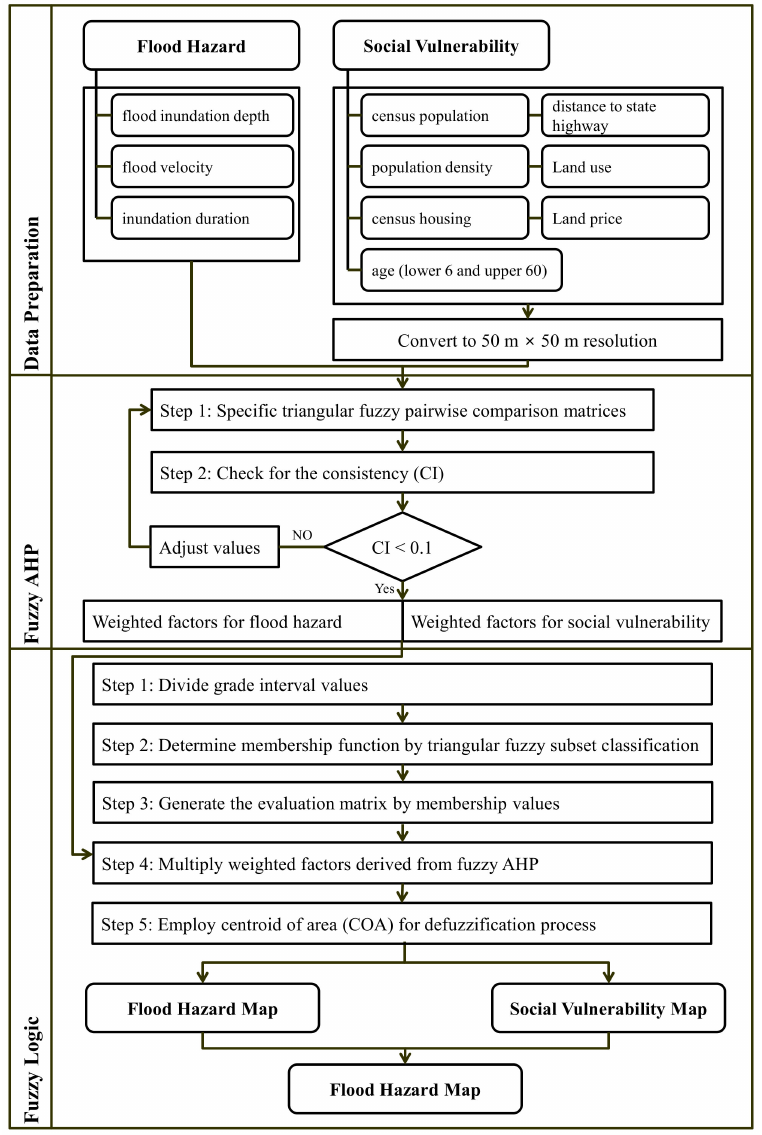
Figure 2. Flowchart for the flood risk